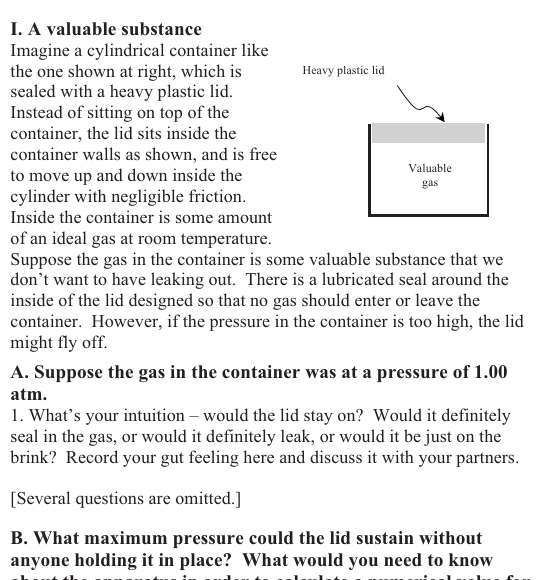
FIG. 5. Excerpt from a tutorial on the ideal gas